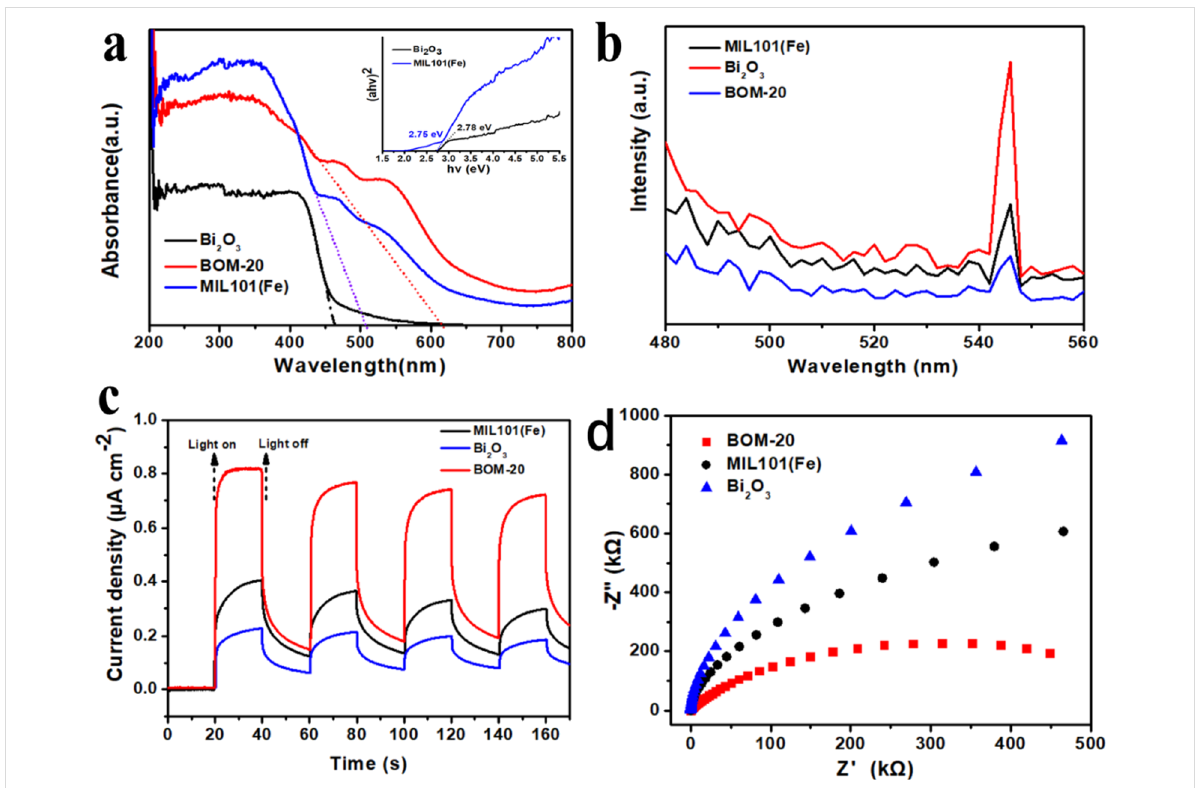
Figure 5: (a) UV–vis spectra, (b) PL spectra, (c) transient photocurrent responses, and (d) EIS spectra of MIL101(Fe), Bi 2 O 3 , and BOM-20.